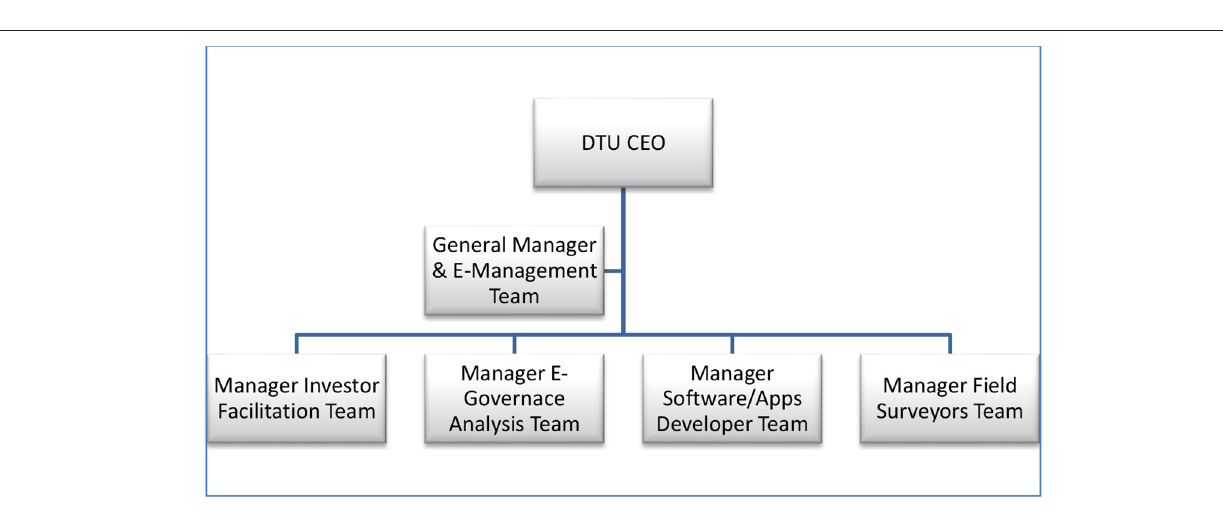
FIGURE 7 | Hierarchical management for